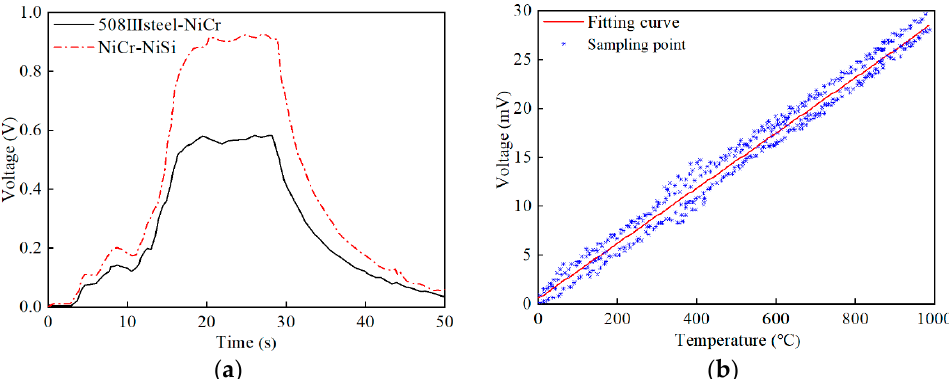
Figure 4. Semi-arti fi cial thermocouple of 508 III steel-NiCr. ( a ) Indexing thermoelectric characteris- Figure 4. Semi-artificial thermocouple of 508III steel-NiCr. ( a ) Indexing thermoelectric characteristics, tics, ( b ) Fi tt ing curve. ( b ) Fitting